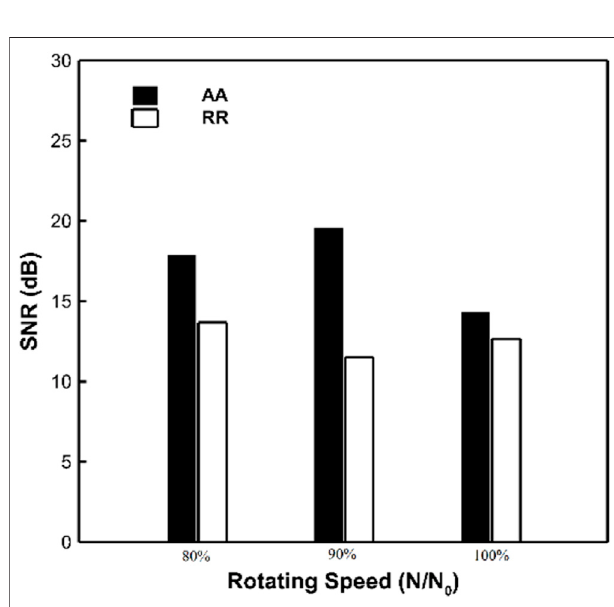
FIGURE 13 | Results of signal-to-noise ratio at different operation